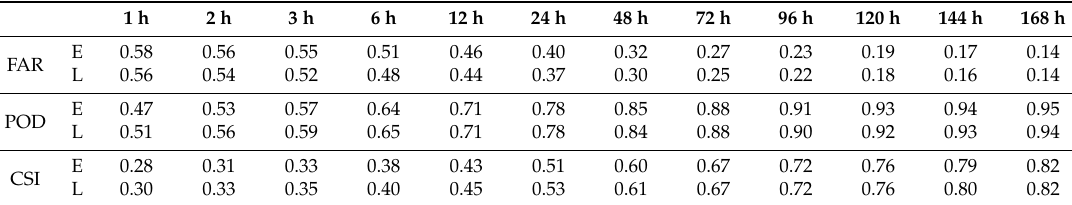
Figure 3. The false alarm ratio ( a ), the probability of detection ( b ) and the critical success index ( c ): The orange boxplot refers to the GPM IMERG half-hourly early data while the red boxplot refers to the GPM IMERG half-hourly late data. Table 3. False alarm ratio (FAR), probability of detection (POD) and critical success index (CSI) mean values calculated both for the early (E) and for the late (L) products.